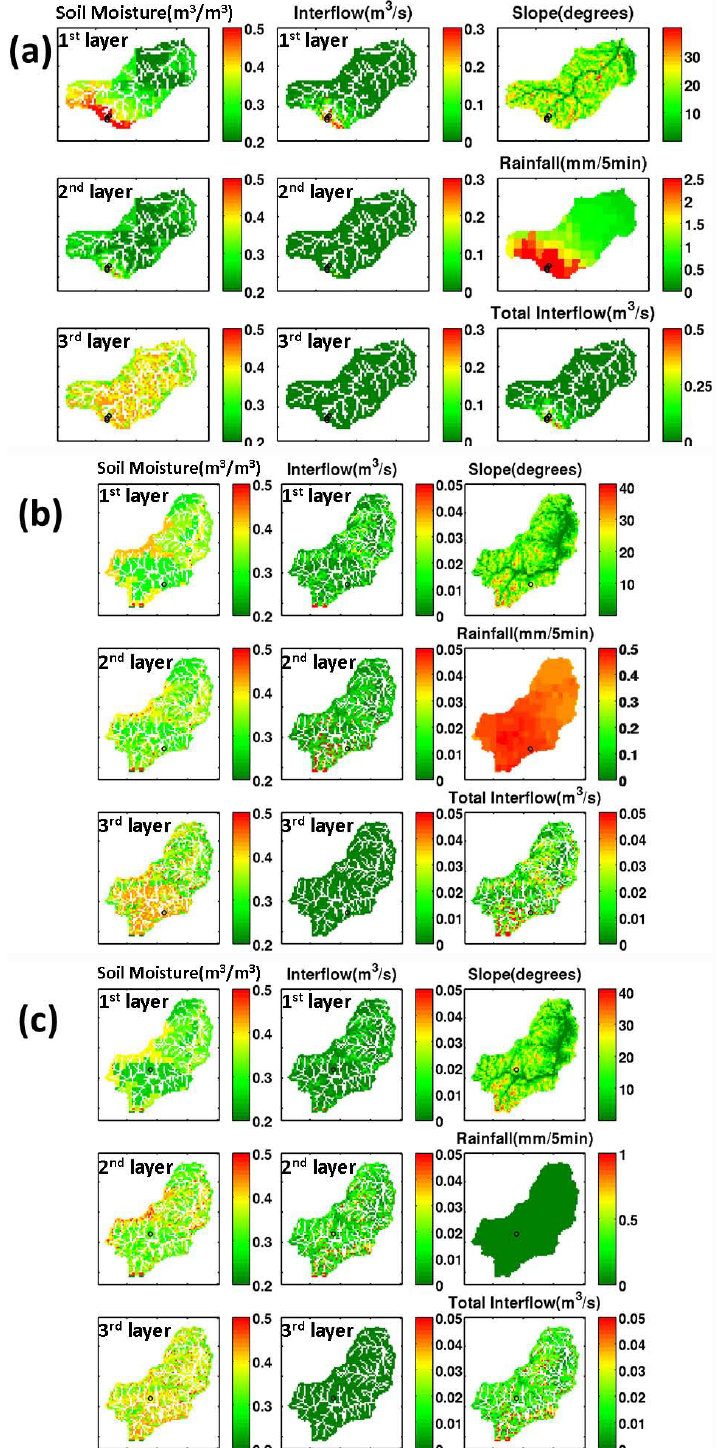
Fig. 10. The spatial distribution of soil moisture, interflow for each soil layer and total interflow in the basins at the time when the debris flow occurred (indicated by dash line in Fig. 9) in July of 2011 (a) , and in January (b) and December (c) of 2009. The debris flow locations are marked by circles. Slope and rainfall rate are also shown for reference. Channel pixels are not